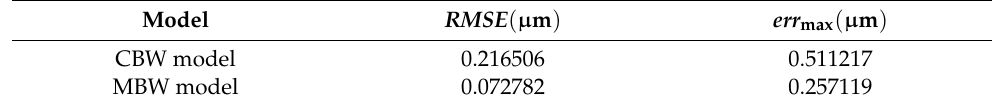
Table 4. Model performance evaluation.